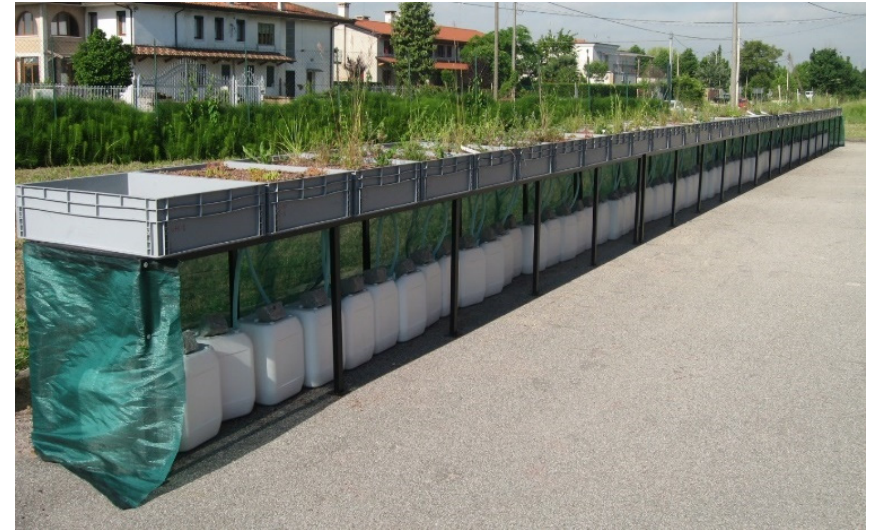
Figure 2. The microcosms of green roofs at the experimental site of Agripolis Campus.